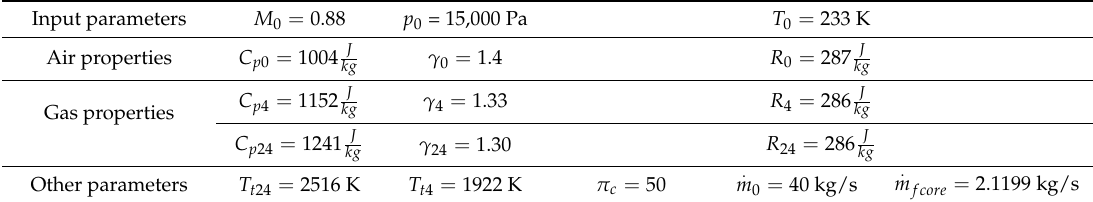
Table 1. Simulation parameters and